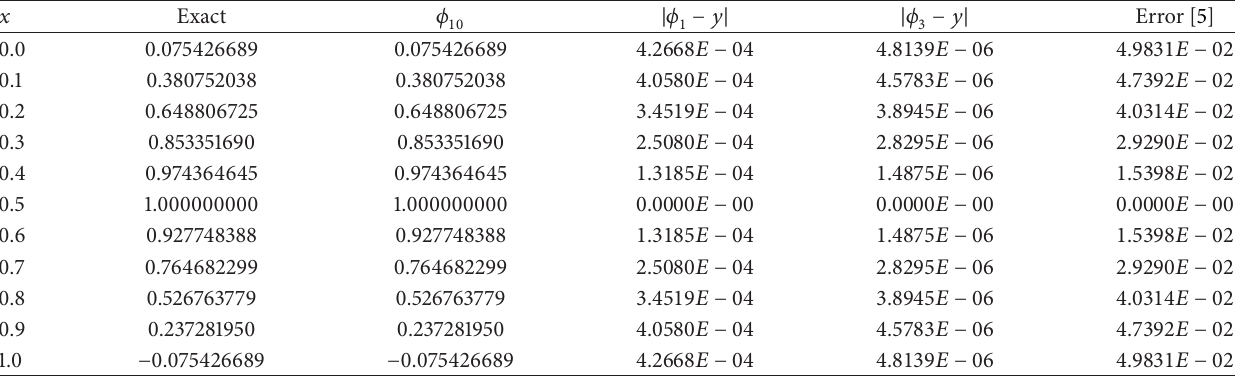
Table 1: Numerical solution and absolute error of Example 4.